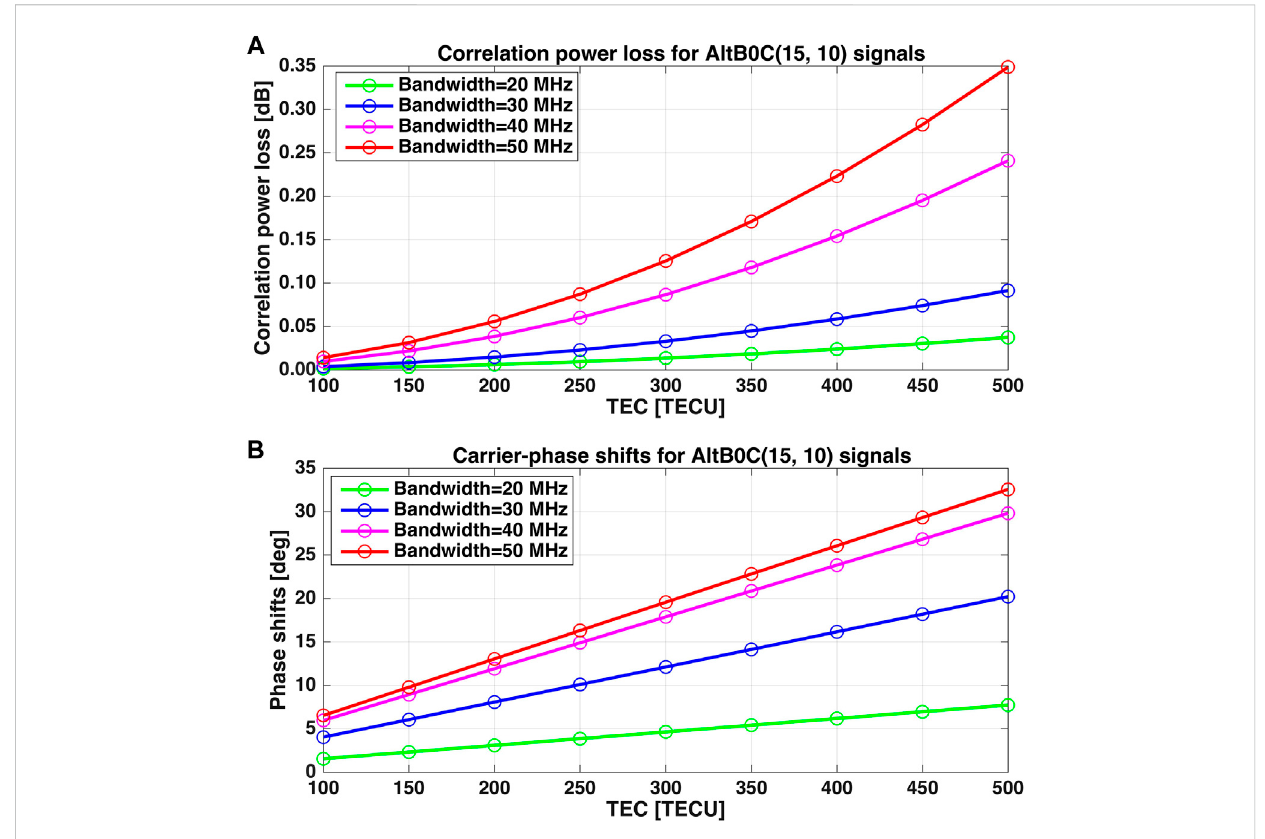
FIGURE 7 Correlation power loss and phase offsets for different